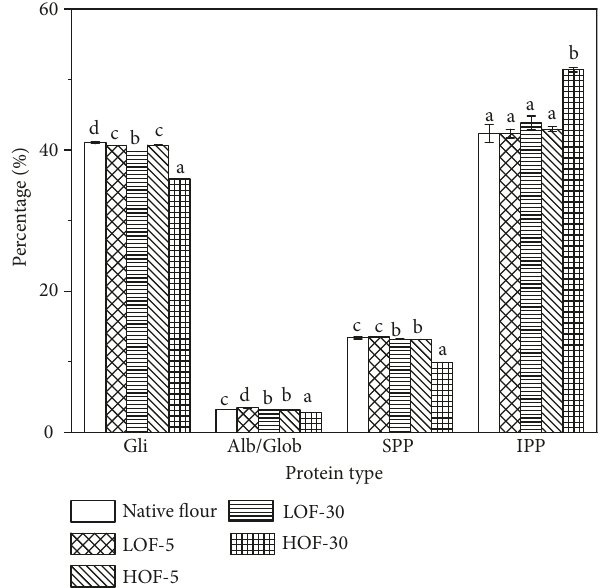
Figure 5: Area percentages of peaks ( T 21 and T 22 ) for LF-NMR analysis of doughs of native and ozone-treated wheat flours. For a specific peak, means with the same letter were not significantly different ( α � 0.05). LOF-5: wheat flour treated at low-intensity condition for 5 min; LOF-30: wheat flour treated at low-intensity condition for 30min; HOF-5: wheat flour treated at high-intensity condition for 5min; HOF-30: wheat flour treated at high-intensity condition for 30min.